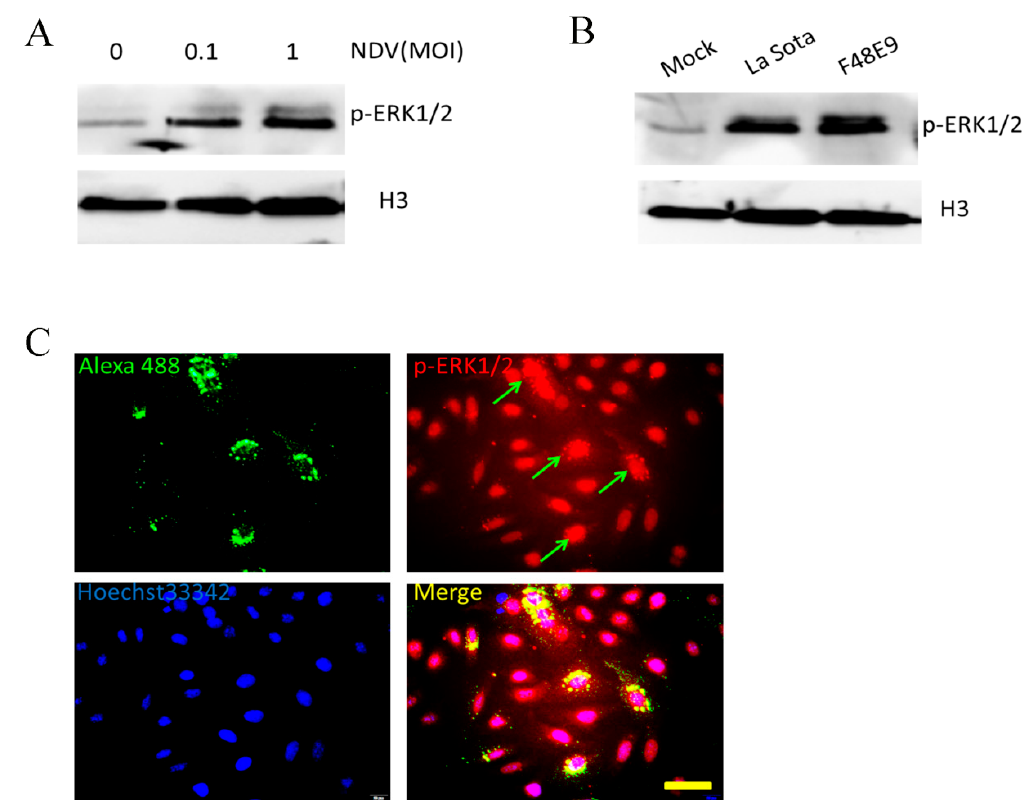
Figure 1. Newcastle disease virus (NDV)-induced phosphorylation of extracellular signal-regulated kinase (ERK)1/2 in HeLa cells. Phospho (p)-ERK1/2 levels in HeLa cells after ( A ) different doses of NDV (F48E9 strain; 1 multiplicity of infection (MOI)) and ( B ) different strains of NDV (La Sota and F48E9; 1 MOI). Cell lysates were analyzed 12 h post-infection by Western blotting using a p-ERK1/2 antibody and H3 histone as the reference. ( C ) HeLa cells were infected with NDV (0.1 MOI). At 12 h post-infection, the cells were stained with chicken anti-NDV serum and a rabbit anti-p-ERK1/2 antibody, which was followed by staining with goat anti-rabbit Alexa Fluor ® 594 (red) and goat anti-chicken IgY Alexa Fluor ® 488 (green) as secondary antibodies. Nuclei were subsequently stained with Hoechst 33342. Images were captured using a Leica fluorescence microscopy (400×), bar = 50 µm.